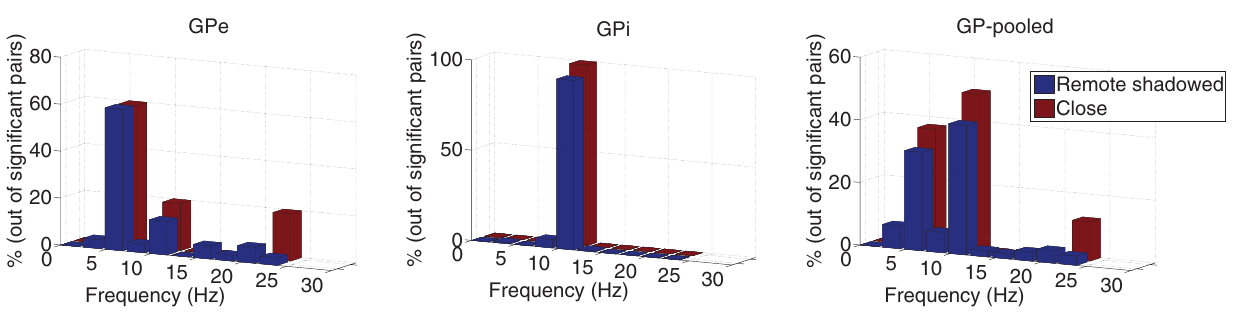
remote ones. Fractional number of remote pairs is the result of different shadowing vectors induced on each remote pair during the artificial shadowing. Most pairs oscillate synchronously at the range of 5–7.5 Hz (approximately the tremor frequency, GPe and GP - pooled only) and 10–12.5 Hz (approximately double tremor frequency). In all three populations, the trend was similar in both the close and artificially shadowed remote pairs.